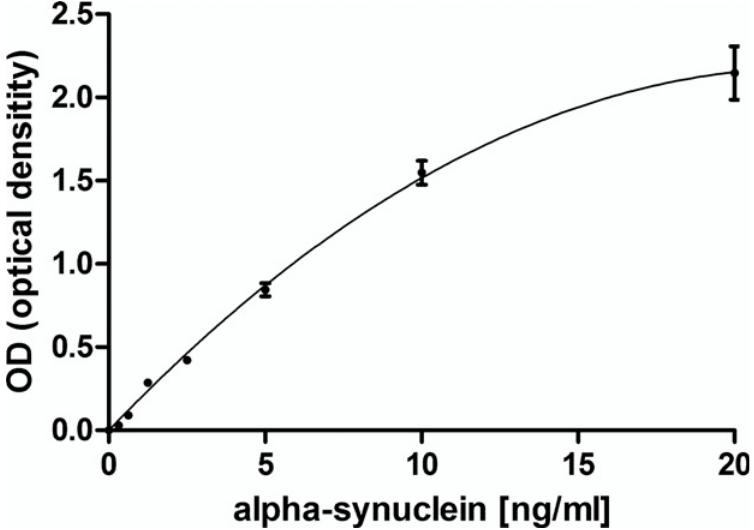
Fig 1. ELISA standard curve for alpha-synuclein. Detection limit of the assay was set at 300 pg/ml (described in results). SD bars are from duplicate measurements.